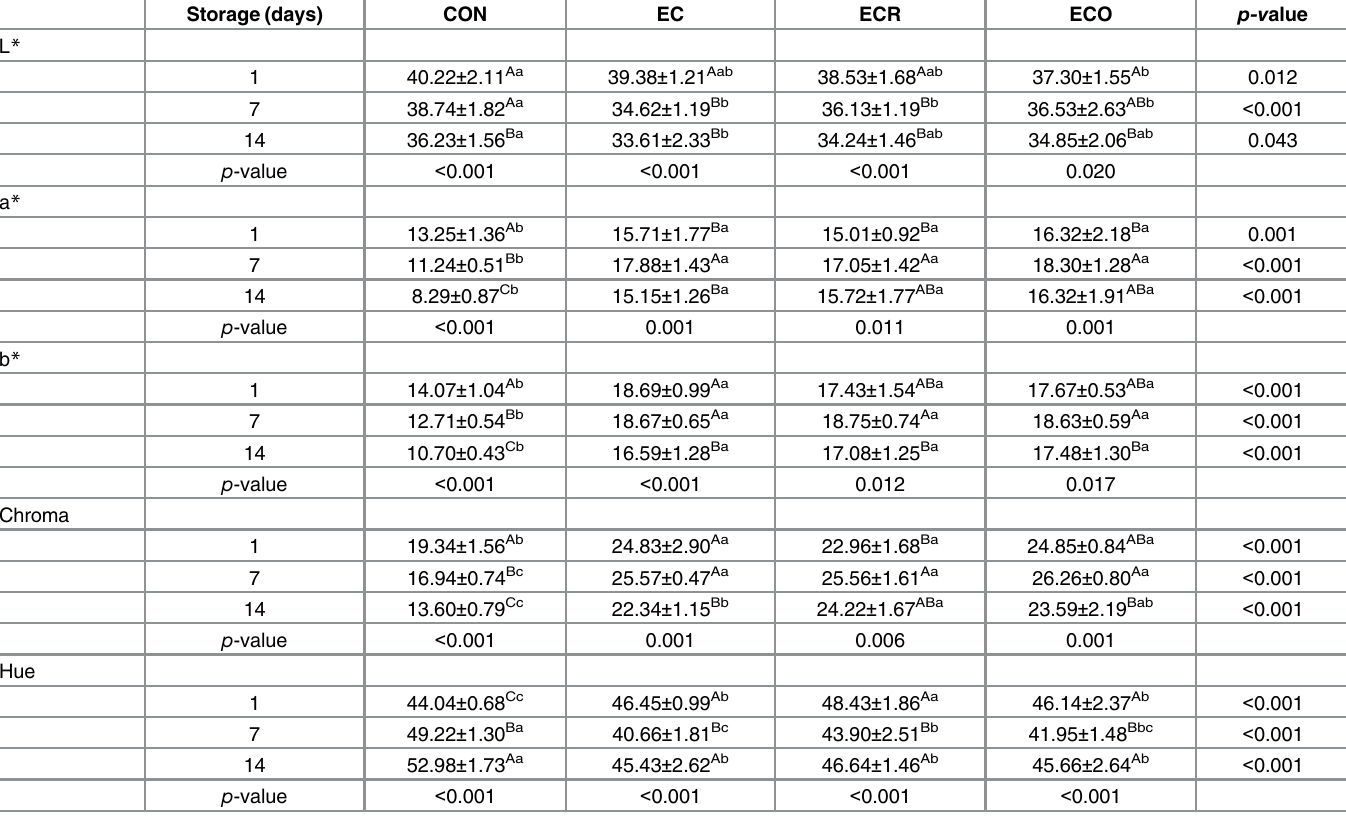
Table 3. L * a * b * , chroma and hue values of meat with and without an edible coating during storage. Storage